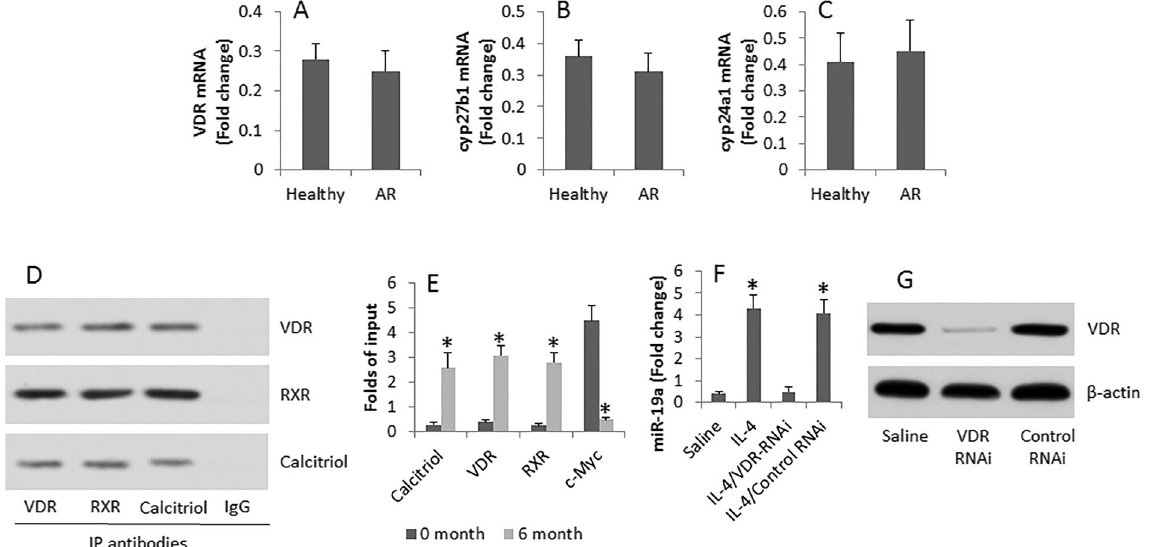
Figure 6. VD3 modulates miR-19a transcription in B cells. ( A – C ) The bars indicate the expression of VDR ( A ), cyp27b1 ( B ) and cyp24a1 ( C ) in peripheral B cells of healthy persons and AR patients. ( D ) The immune blots indicate a complex of VDR, RXR and calcitriol in peripheral B cells of AR patients at month 6 after the commerce of the therapy of SIT/VD3. ( E ) The bars indicate the levels of calcitriol, VDR, RXR and c-Myc at the miR-19a promoter locus. ( F ) The bars indicate the miR-19a levels in B cells after the treatment denoted on the X axis. ( G ) The immune blots show the VDR RNAi results in B cells. The data are representative of 3 independent experiments. Data of bars are presented as mean ± SD. * p < 0.01, compared with “0” month ( E ) or saline group ( F ). The full-length gels and blots are included in the supplementary